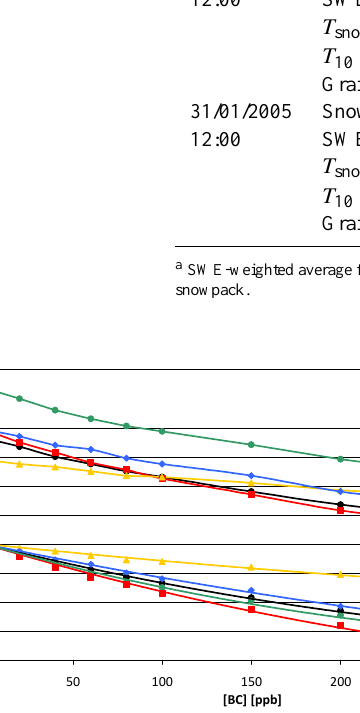
Figure 6. Top: simulated average albedo for several periods with continuous snow higher than 10cm as a function of BC concen- tration. Bottom: normalized albedo as differences of the averaged albedo minus the averaged albedo at BC = 0. The lines correspond to the best fit of a quadratic polynomial forced through zero for each set of the normalized